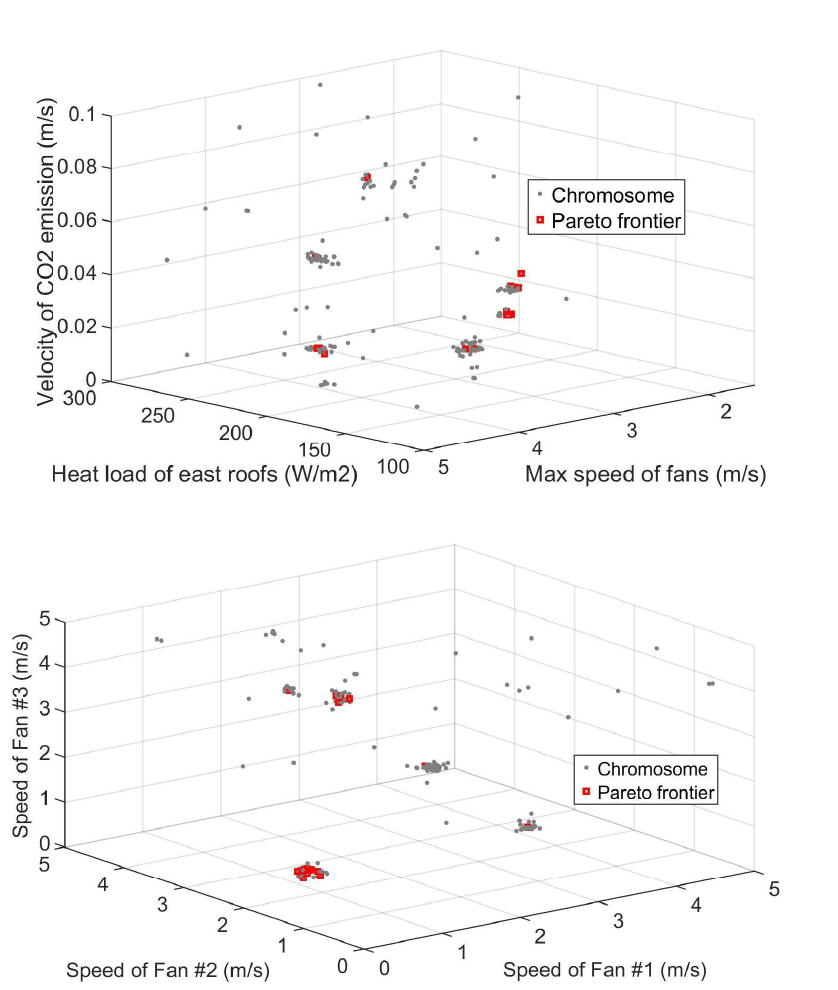
Figure 13. Tri-dimensional projections of the multiple control variables represented by particles (top projection: CO 2 emission speed - heat load of roofs - max speed of fans; bottom projection: speed of fan